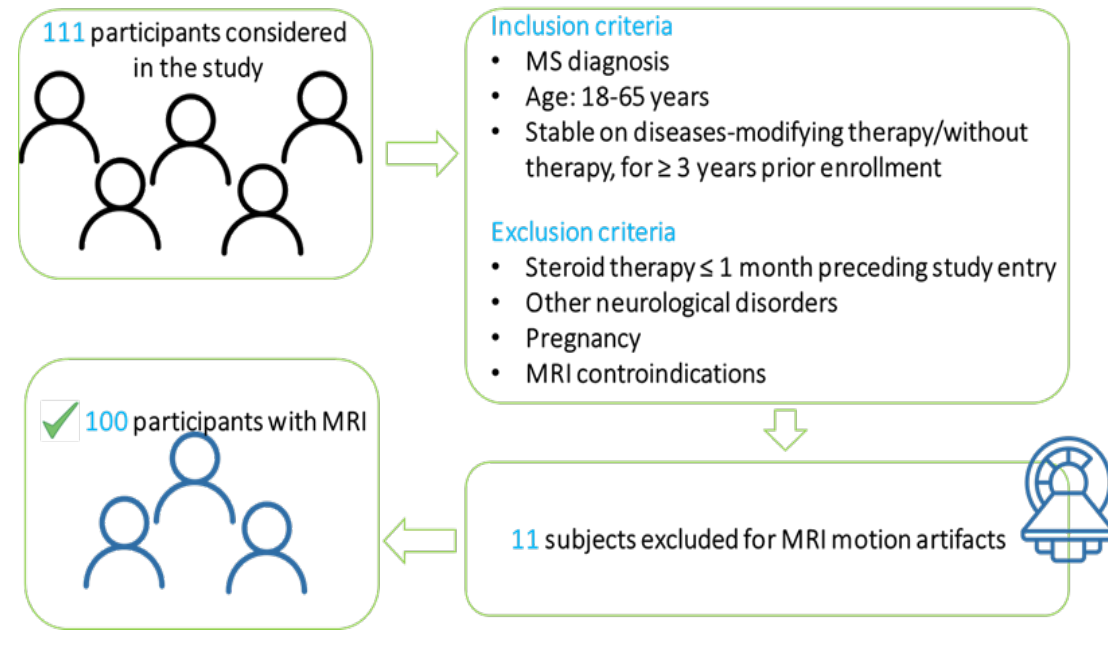
Figure 1. Study inclusion criteria.